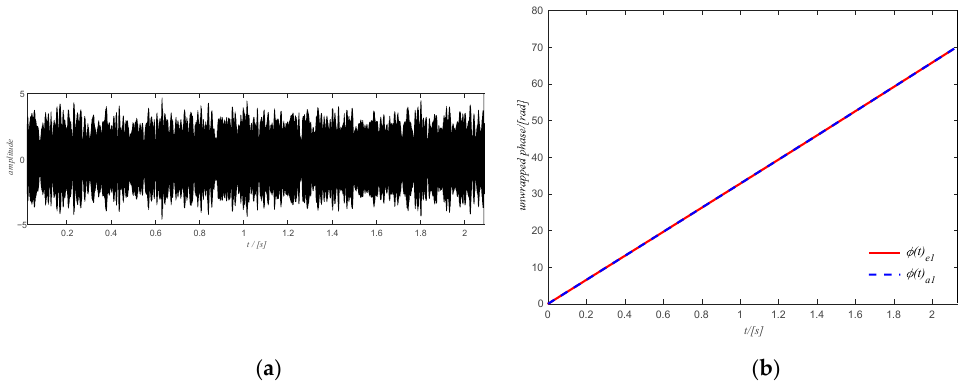
Figure 16. ( a ) The shaft rotation speed of case study 1; ( b ) the filtered spectrum of the selected Figure16. ( a )Theshaftrotationspeedofcasestudy1; ( b )thefilteredspectrumoftheselectedcomponent. component.